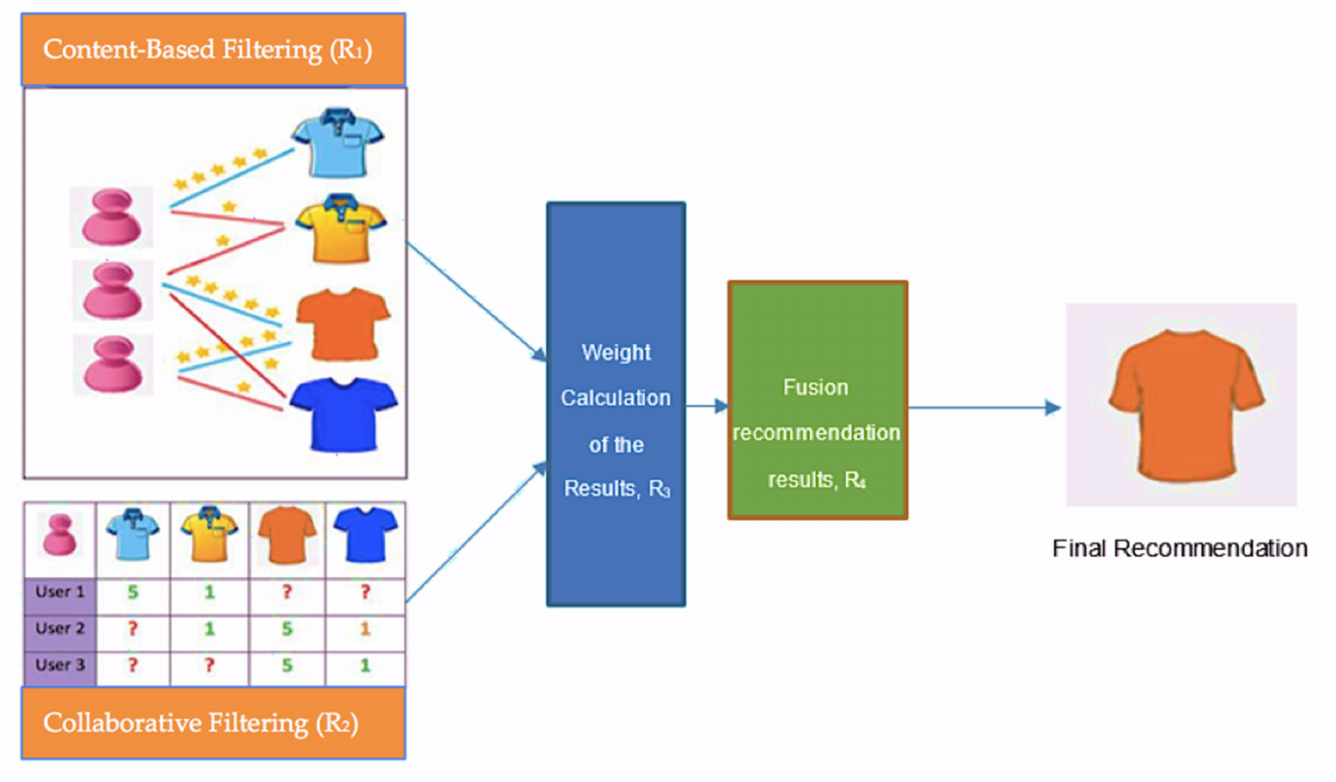
Figure 6. Hybrid filtering